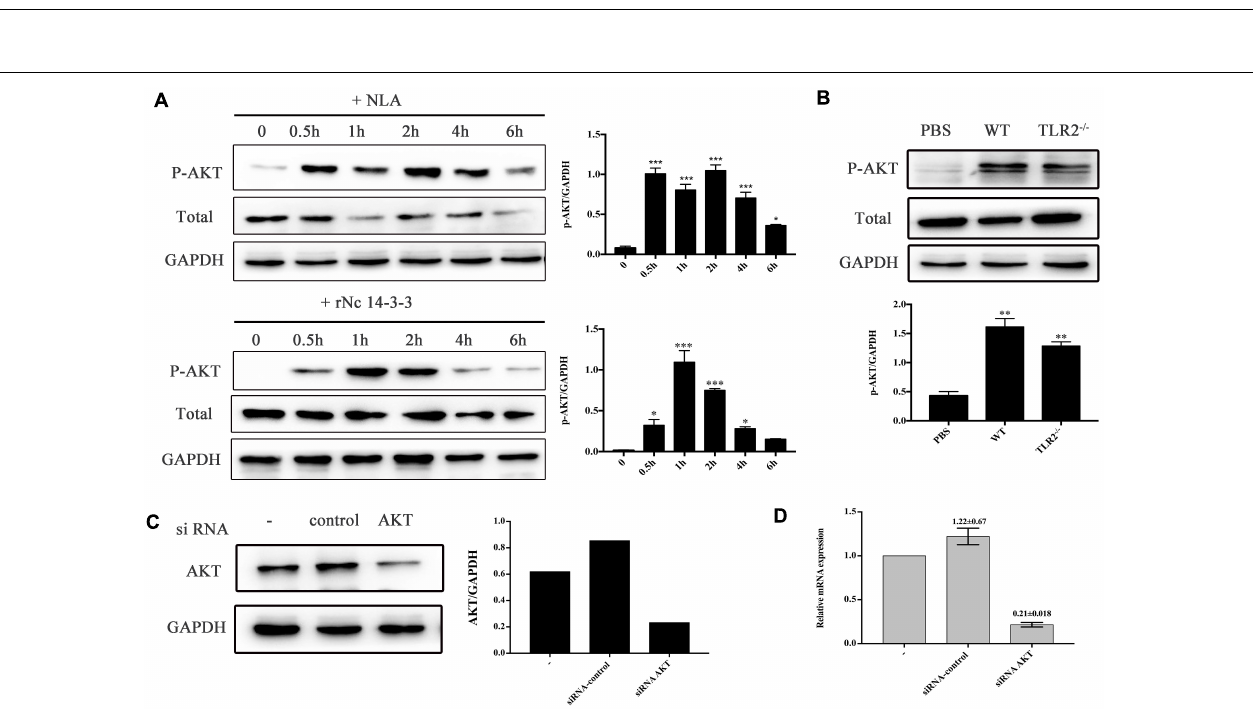
FIGURE 5 | Recombinant Nc14-3-3-mediated cytokine production was decreased after blocking the MAPK signaling pathways. WT mouse PMs were pretreated with or without the SB203580 (p38), PD98059 (ERK) and SP600125 (JNK) inhibitors before incubated with rNc14-3-3 or N. caninum lysate antigen (NLA) for 24 h. The production of IL-6, IL-12p40, and TNF- α in the supernatants was measured by ELISA. Data are expressed as the mean ± SD from three separate experiments. ∗ P < 0.05; ∗∗ P < 0.01; ∗∗∗ P < 0.001 for the inhibitor-treated group versus the Nc14-3-3 group or the inhibitor-treated group versus the NLA group.